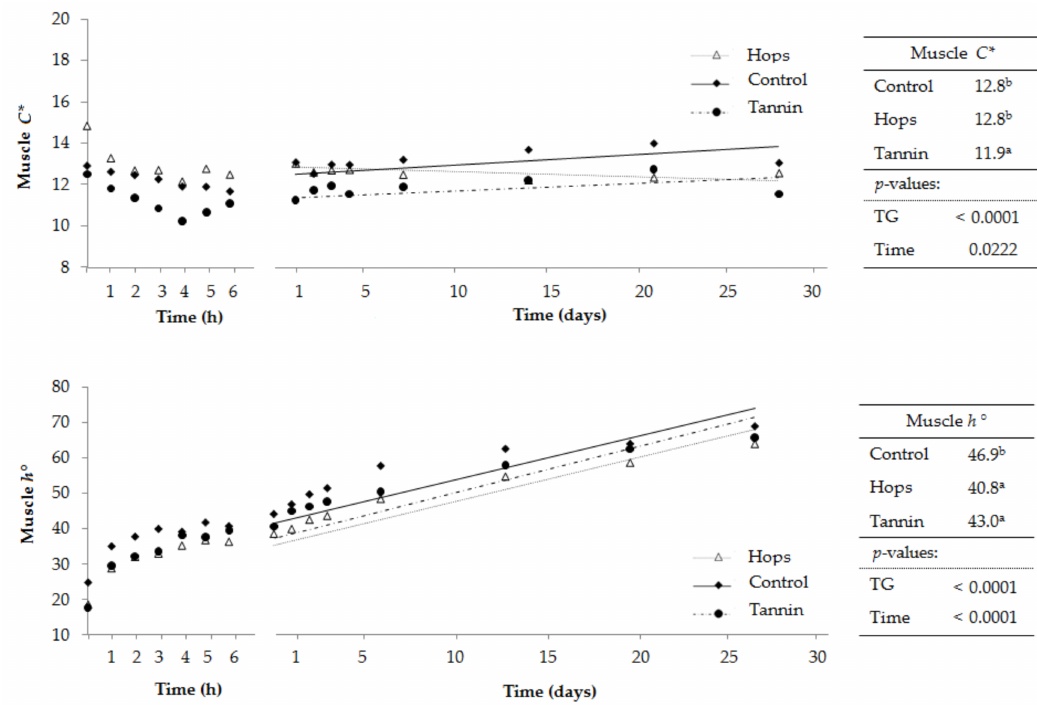
Figure 5. Objective color parameters: Chroma: C * and hue angle — h ◦ of muscle of dry-cured bellies during refrigerated storage with lsmeans and p -values for treatment group (TG) and time e ff ects ( abc intercepts ascribed di ff erent superscript letters are significantly di ff erent at p -value <